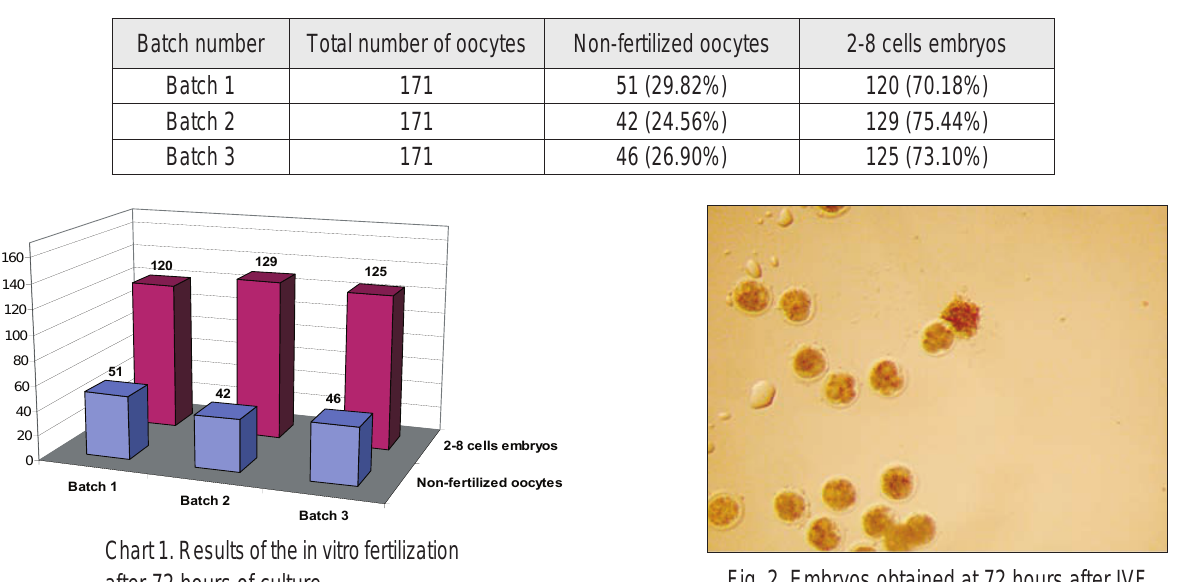
Table 1. Results of the in vitro fertilization after 72 hours of culture